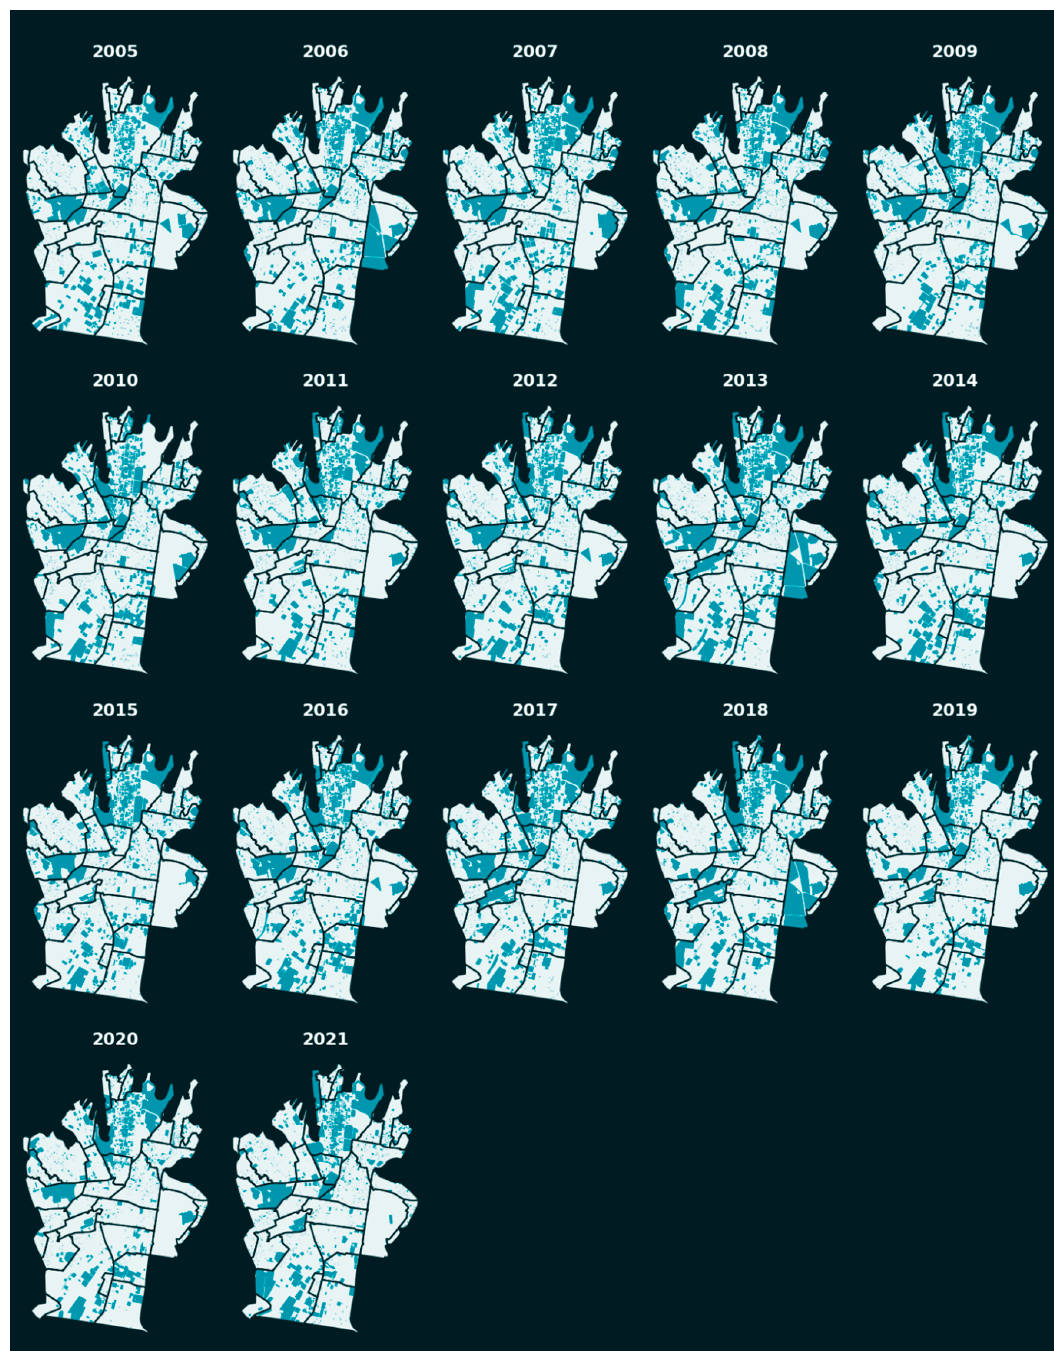
Figure 19. Locations of DAs by year marked in blue